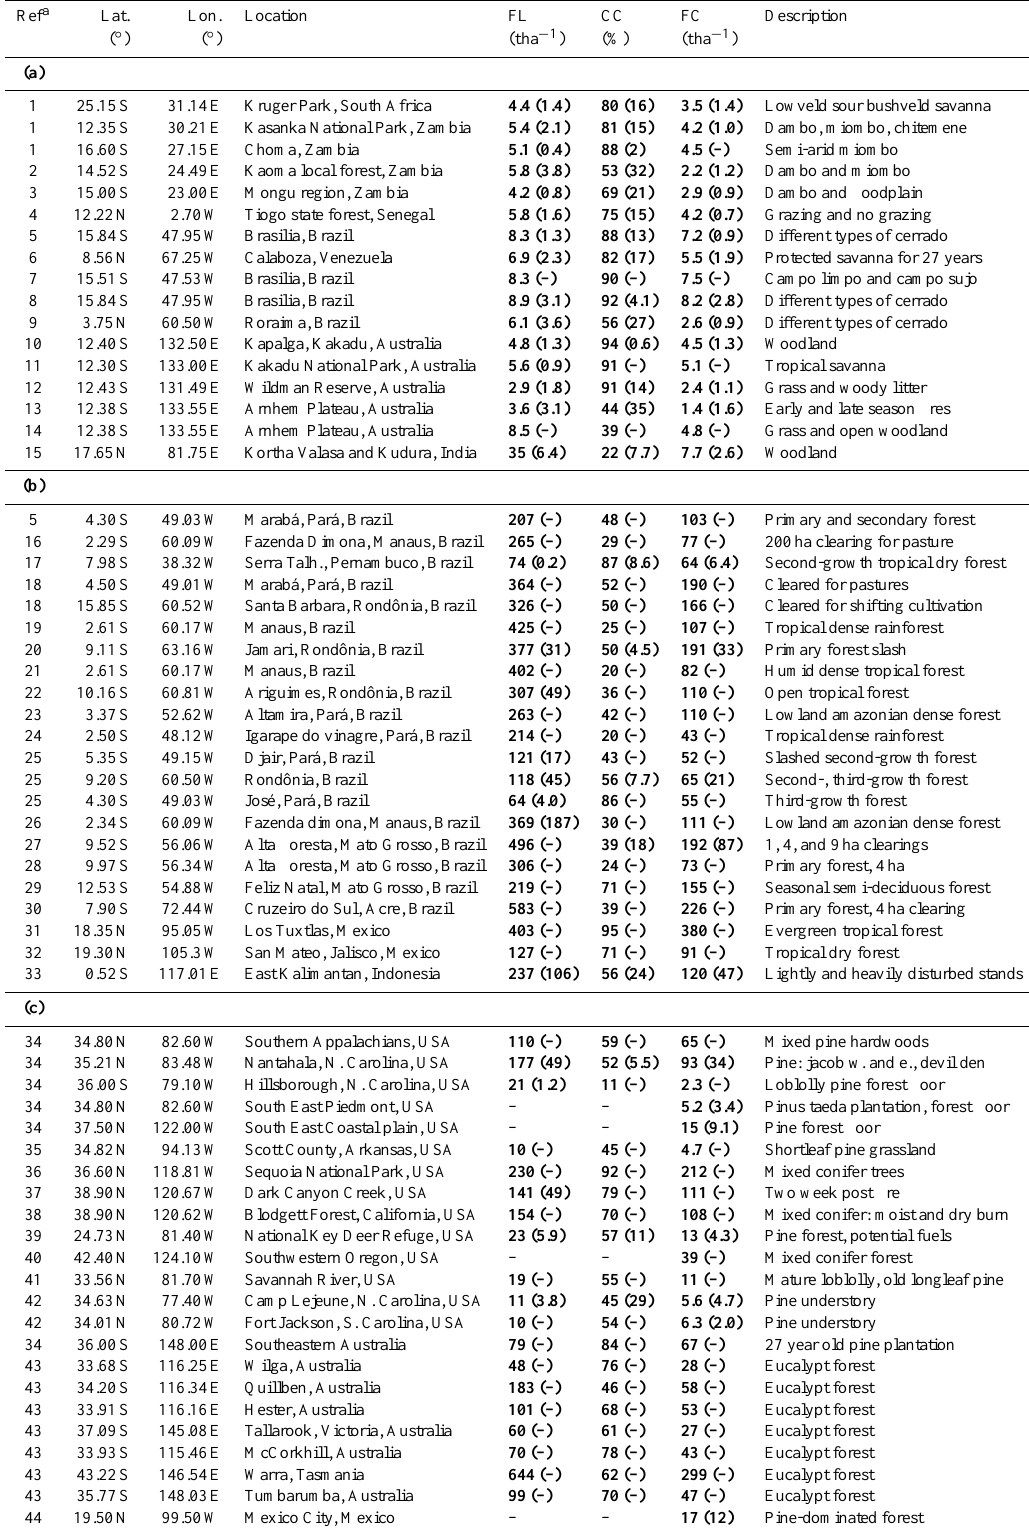
Table 1. Location, fuel load (FL), combustion completeness (CC) and fuel consumption (FC) for field measurements conducted in the savanna (a) , tropical forest (b) , temperate forest (c) , boreal forest (d) , pasture (e) , shifting cultivation (f) , crop residue (g) , chaparral (h) , tropical peat (i) , boreal peat (j) , and tundra biome (k) . Standard deviation (SD) is shown in parenthesis, and values indicated in bold were used to calculate the biome